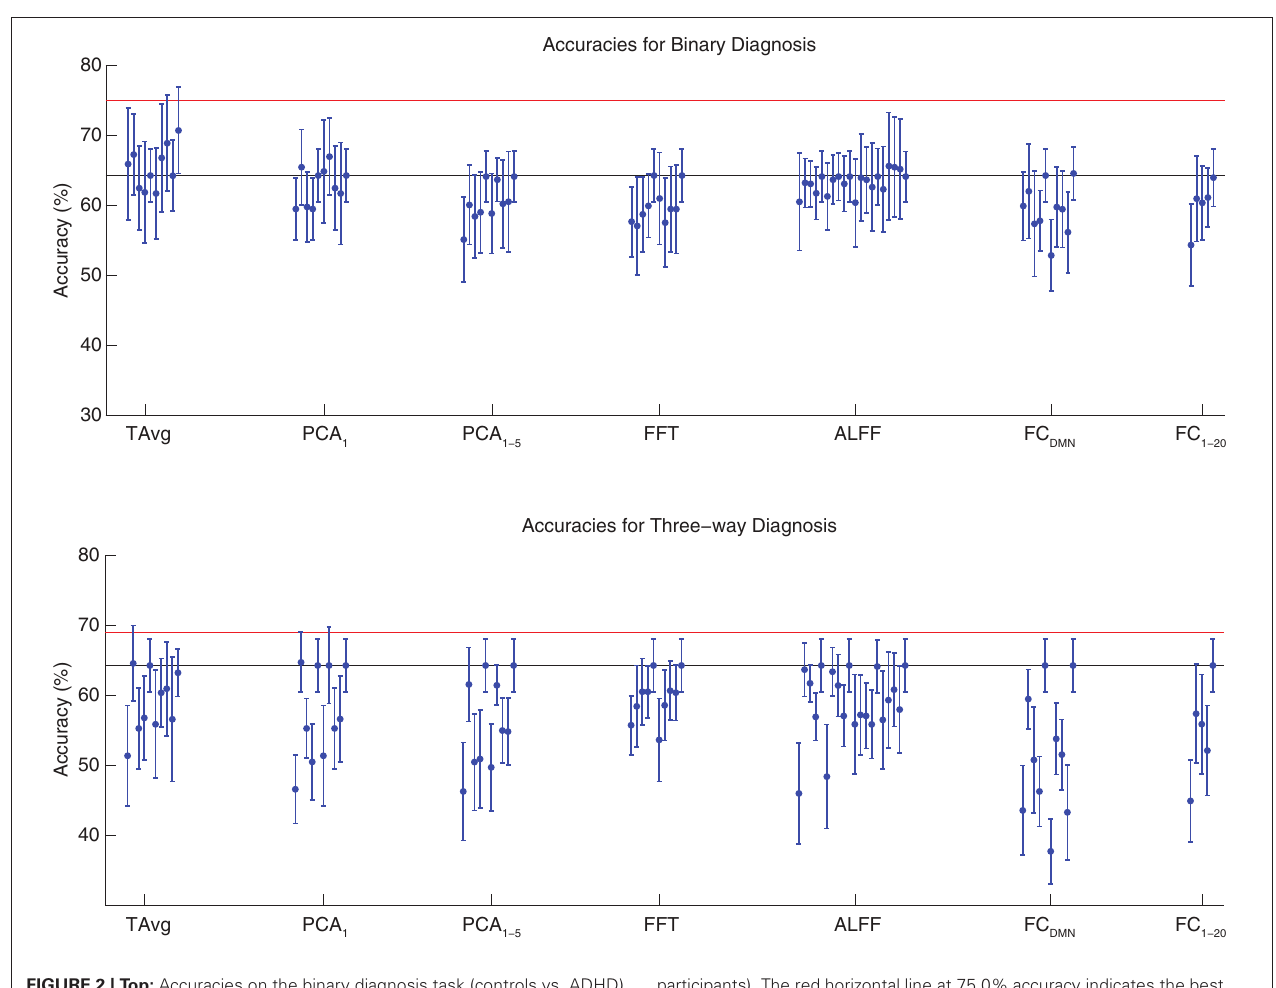
participants). The red horizontal line at 75.0% accuracy indicates the best mean accuracy achieved with binary diagnosis on the Training Dataset using personal characteristic input data (section 3.1). Bottom : Accuracies on the three-way diagnosis task (controls vs. ADHD-C vs. ADHD-I) using same Diagnostic Pipelines as in top panel . The red horizontal line at 69.0% accuracy indicates the best mean accuracy achieved with three-way diagnosis on the Training Dataset using personal characteristic input data (section 3.1). Other conventions as in top panel